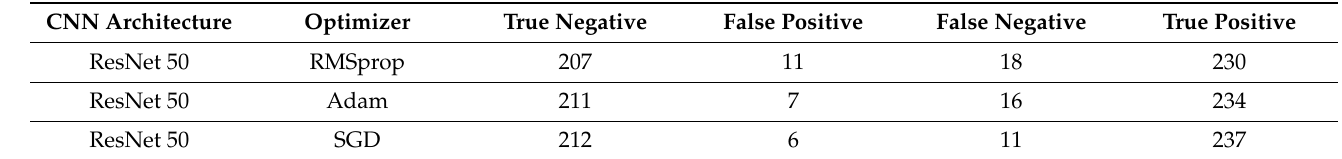
Table 8. ResNet 50 confusion matrix (validation).